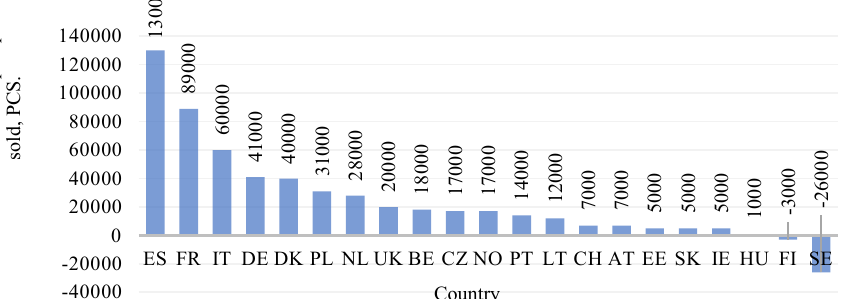
Fig. 1. Heat pump market growth in